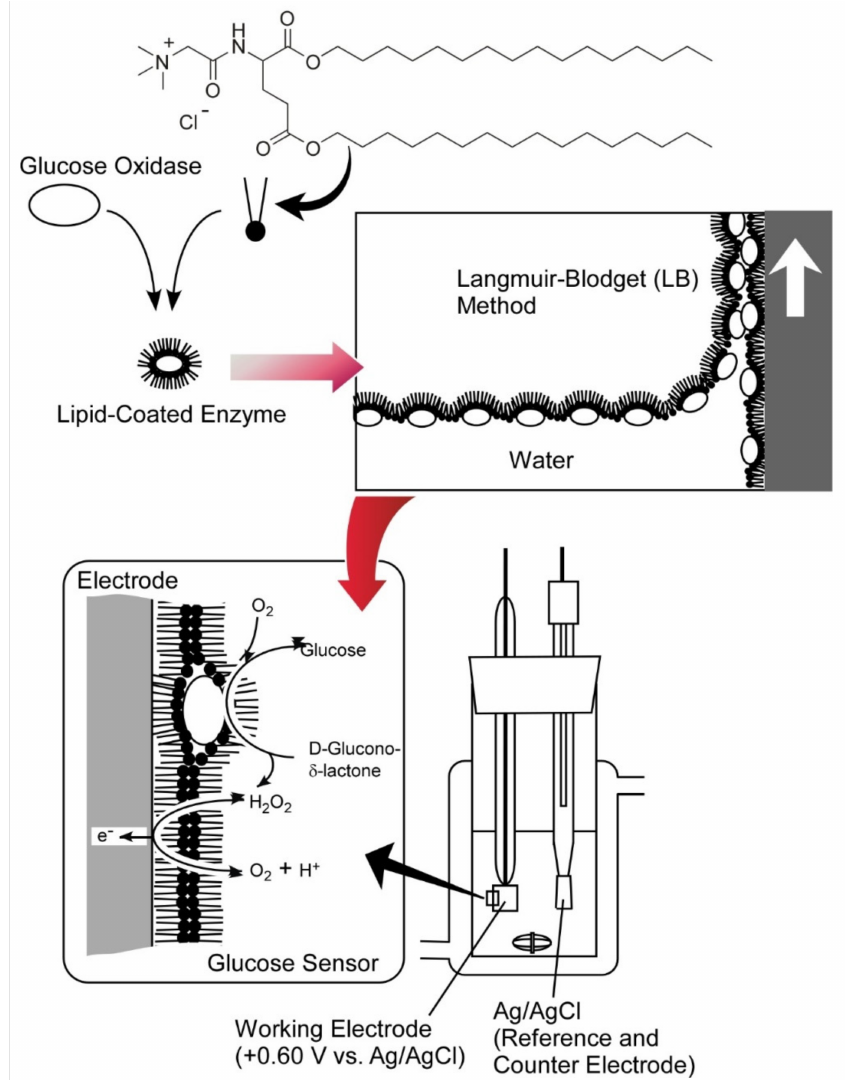
Figure 25. Monolayer transfer of the lipid-coated glucose oxidase onto electrode surface for prepara- tion of sensitive sensors for glucose